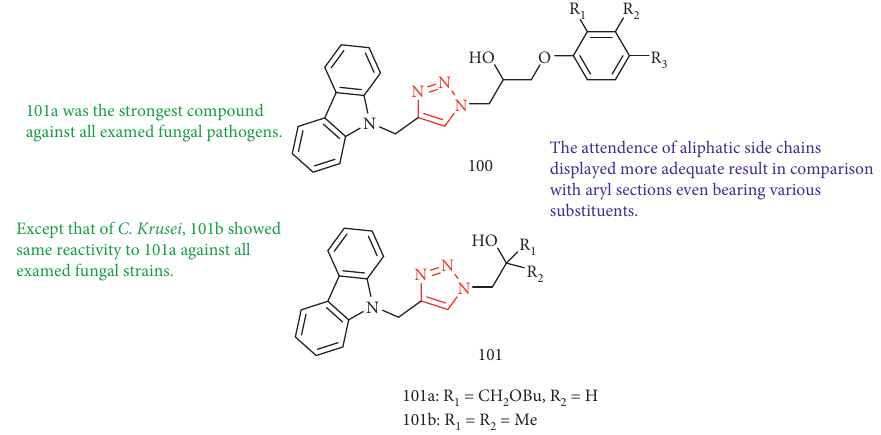
Figure 45: Chemical structure of novel 1,2,3-triazolyl β -hydroxy alkyl/carbazole hybrid